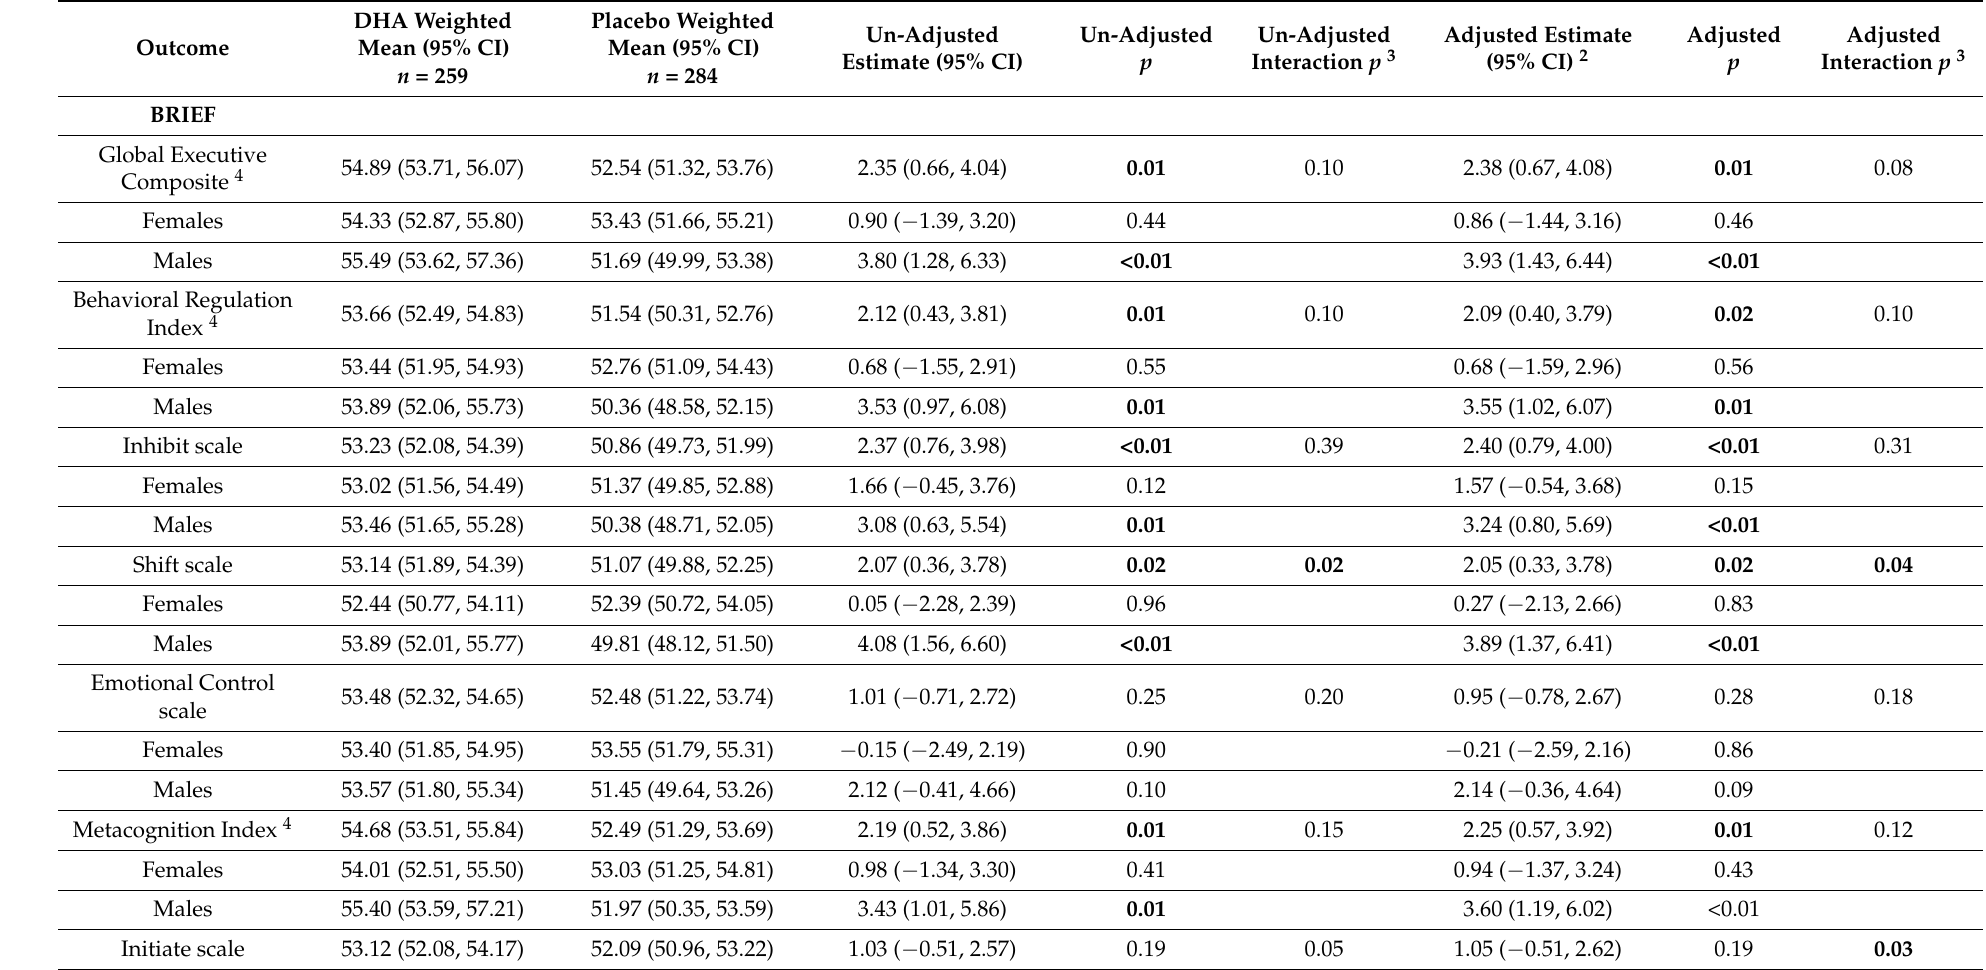
Table 2. Parent-reported outcomes of behavior at 7 years of age 1